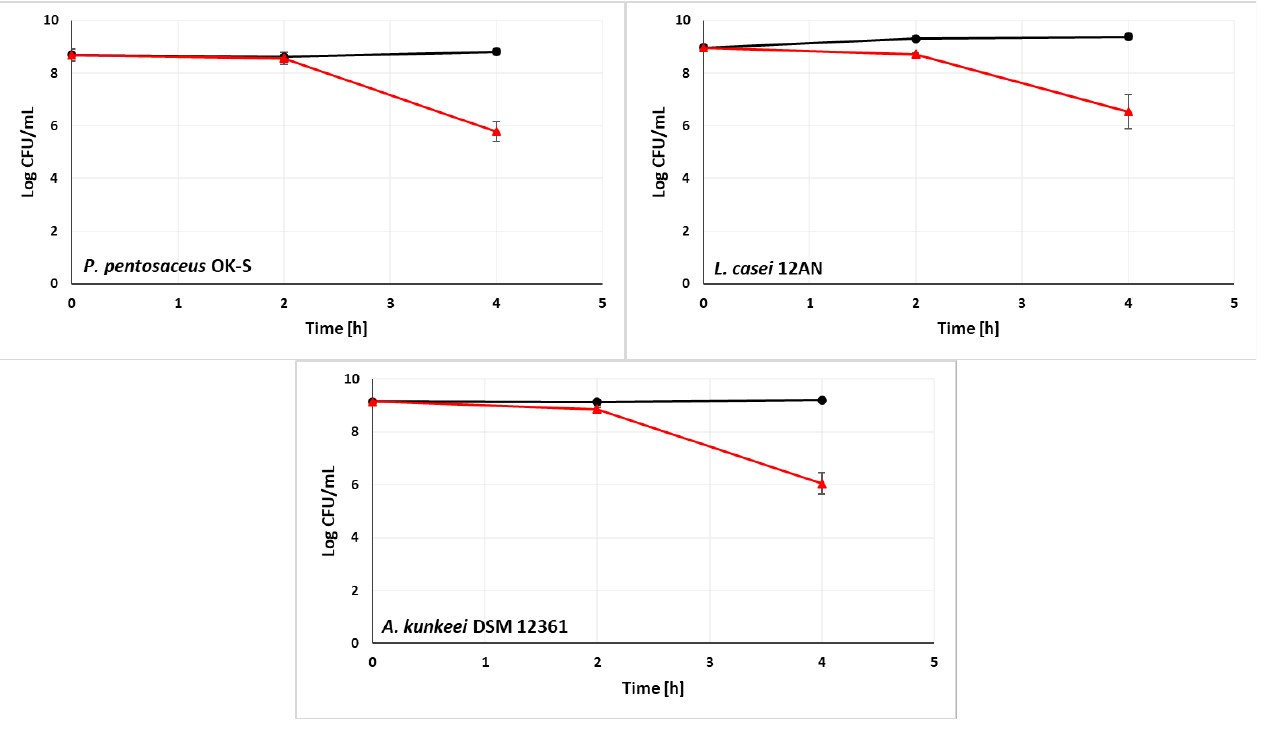
Figure 2. Resistance of lactic acid bacteria (LAB) strains to gastric ( t < 2 h) and intestinal ( t > 2 h) conditions. The black line (square markers) indicates pure LAB culture (control) and the red line (triangular markers) indicates LAB incubated with gastric and intestinal juices. Results are pre- sented as mean ± standard deviation.